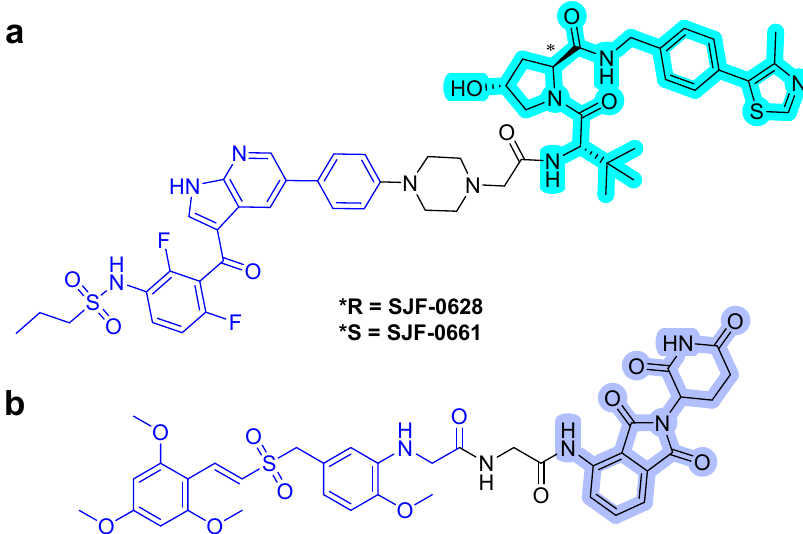
Figure 9. BRAF degrader. ( a ) Vemurafenib-based PROTAC. ( b ) Rigosertib-CRBN PROTAC. A stereocenter is indicated by an asterisk. The colors show the part of each compound that is a structurally important binding motif. The ligands of the POI are in blue. VHL and CRBN ligands are highlighted in cyan and purple, respectively.